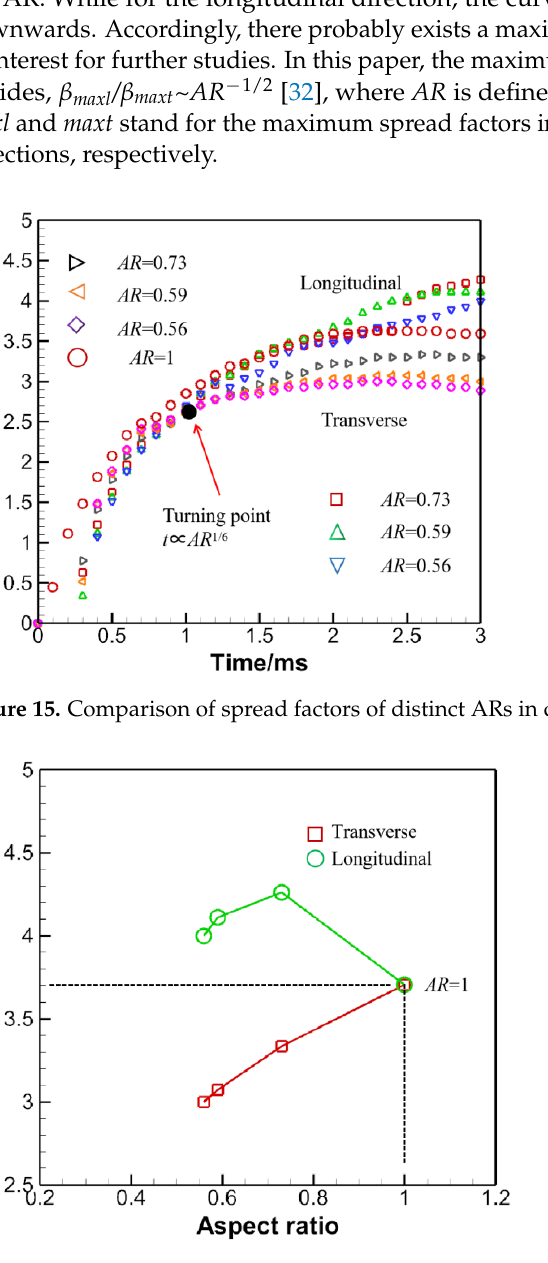
Figure 16. Maximum spread factors for different ARs for the oblate drop impact. 3.5. Prolate Droplet Impingement with an 90° Impacting Angle Prolate is another non-spherical shape occurring in industrial applications. Prolate shape may help an air bubble rise in a water solution, since the drag coefficient could be dramatically decreased. This special shape could be realized by introducing electric or magnetic force along an interface, which will stretch the interface in the direction of the applied field [33]. Figure 17 presents the numerical outcome on prolate droplet impact. It is to be noted that the AR decreases from 1.81 to 1.68 to 1.36 to 1 from top to bottom, that